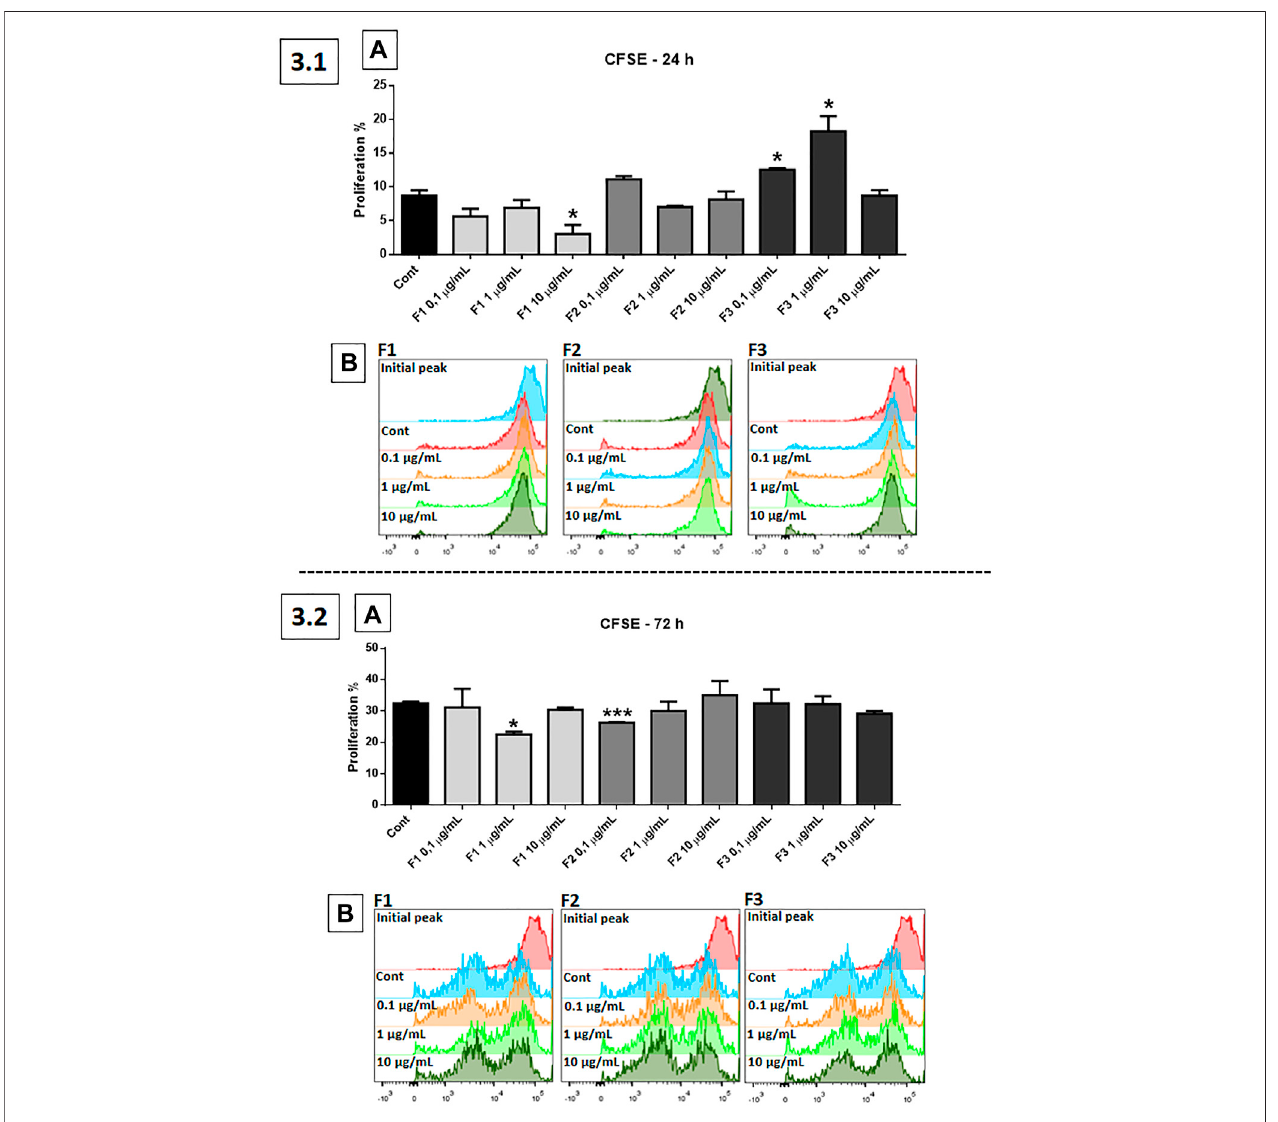
FIGURE 3 | Proliferation test using CFSE probe: human GB cells treated with F1, F2, and F3 (0.1, 1, and 10 μ g/ml). 3.1 (A) After 24 h of treatment, F1 at 10 μ g/ml was the most effective in reducing proliferation, while F3 at 0.1 and 1 μ g/ml signi fi cantly increased GB cell proliferation, compared to control. 3.1 (B) Representative histogram. 3.2 (A) After 72 h of treatment, F1 at 1 μ g/ml and F2 at 0.1 μ g/ml were signi fi cantly effective in reducing the proliferation of GB cells. 3.2 (B) Representative histogram. One-way ANOVA followed by Dunnett ’ s multiple comparisons test; unpaired Student ’ s t-tests were used to compare each treatment with the control. * p < 0.05, ** p < 0.01, *** p < 0.001, **** p < 0.0001, compared to the control